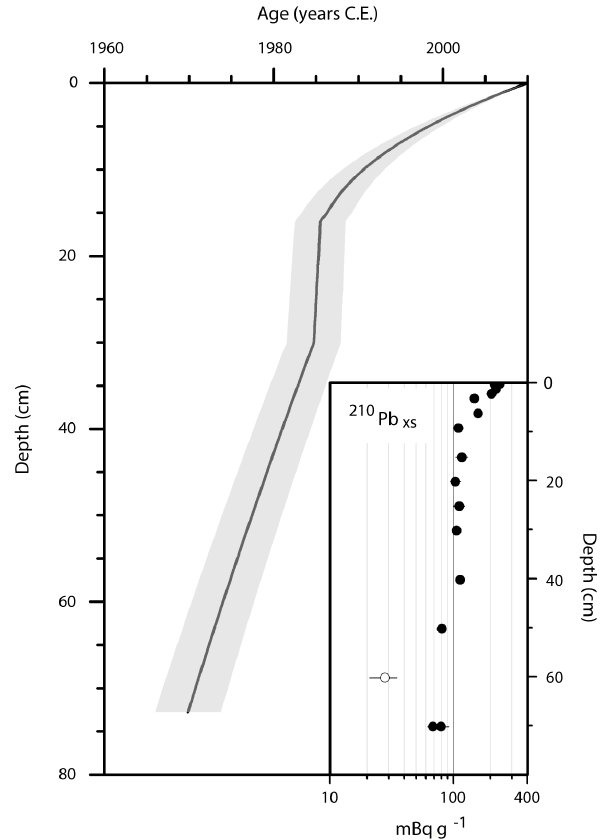
Figure 2. DTCI2010 chronology, based on 210 Pb excess ( 210 Pb xs ) and associated age model errors (grey area). The inset corresponds to the downcore profile of 210 Pb xs (error bars correspond to